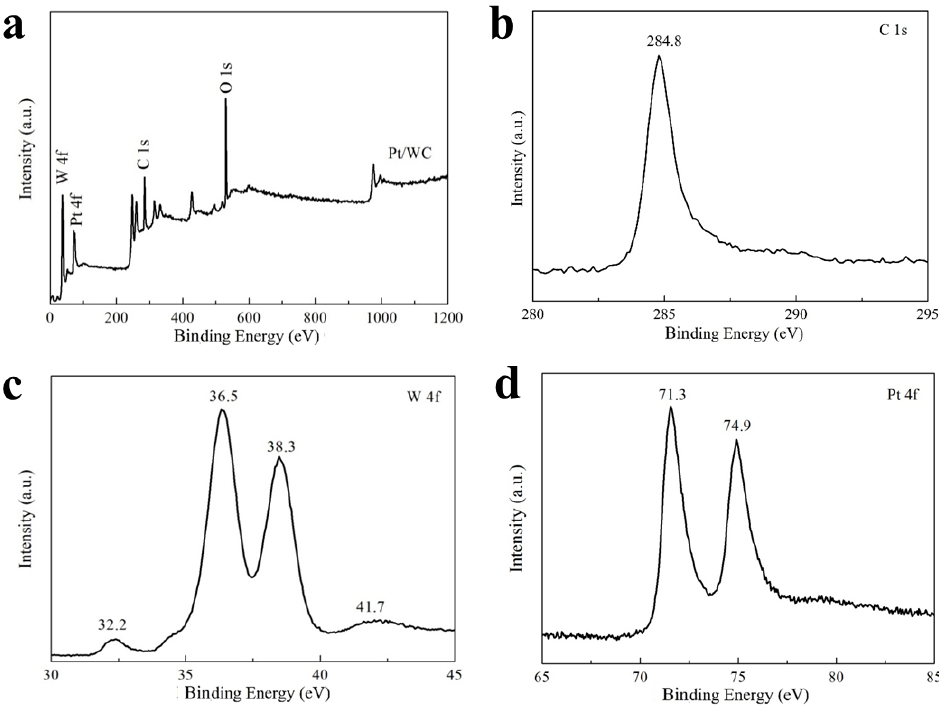
Figure 4. ( a ) XPS spectra of Pt/WC catalyst; ( b ) C 1s peak; ( c ) W4f peak; ( d ) Pt 4f peak.